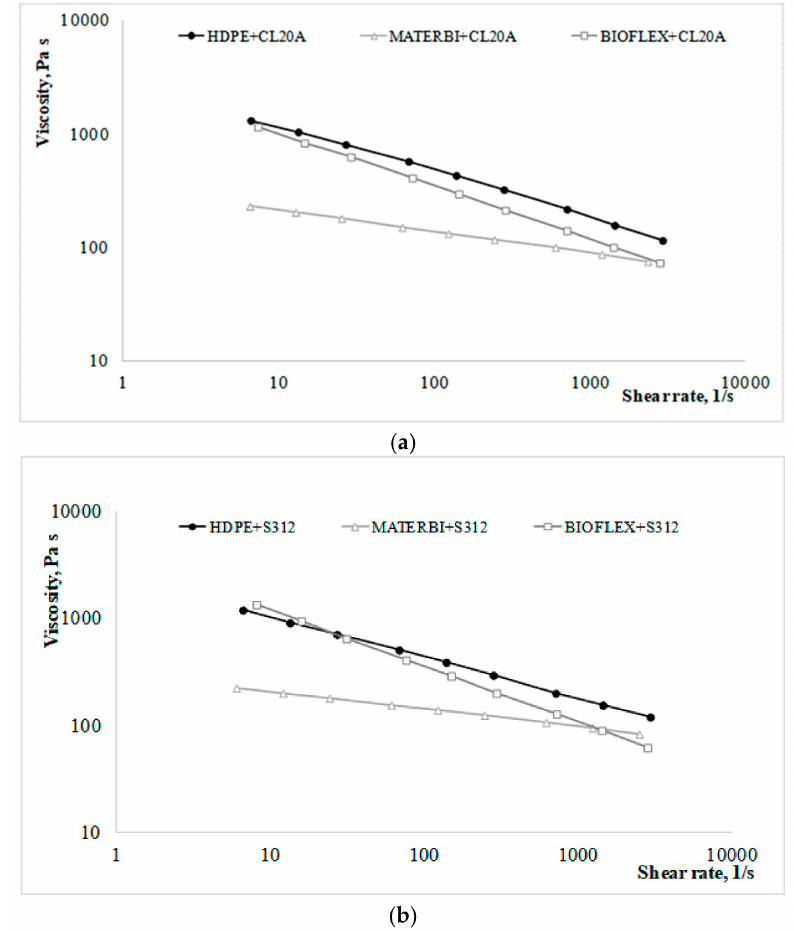
Figure 3. ( a ) Rheological curves of the different CL20A-containing nanocomposites; ( b ) Rheological curves of the different S312-containing